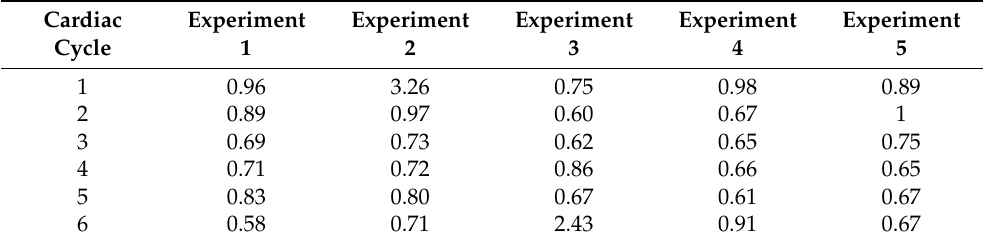
Table 12. Experimental PRT measured in second(s) for each cardiac cycle for patient 1. Cardiac